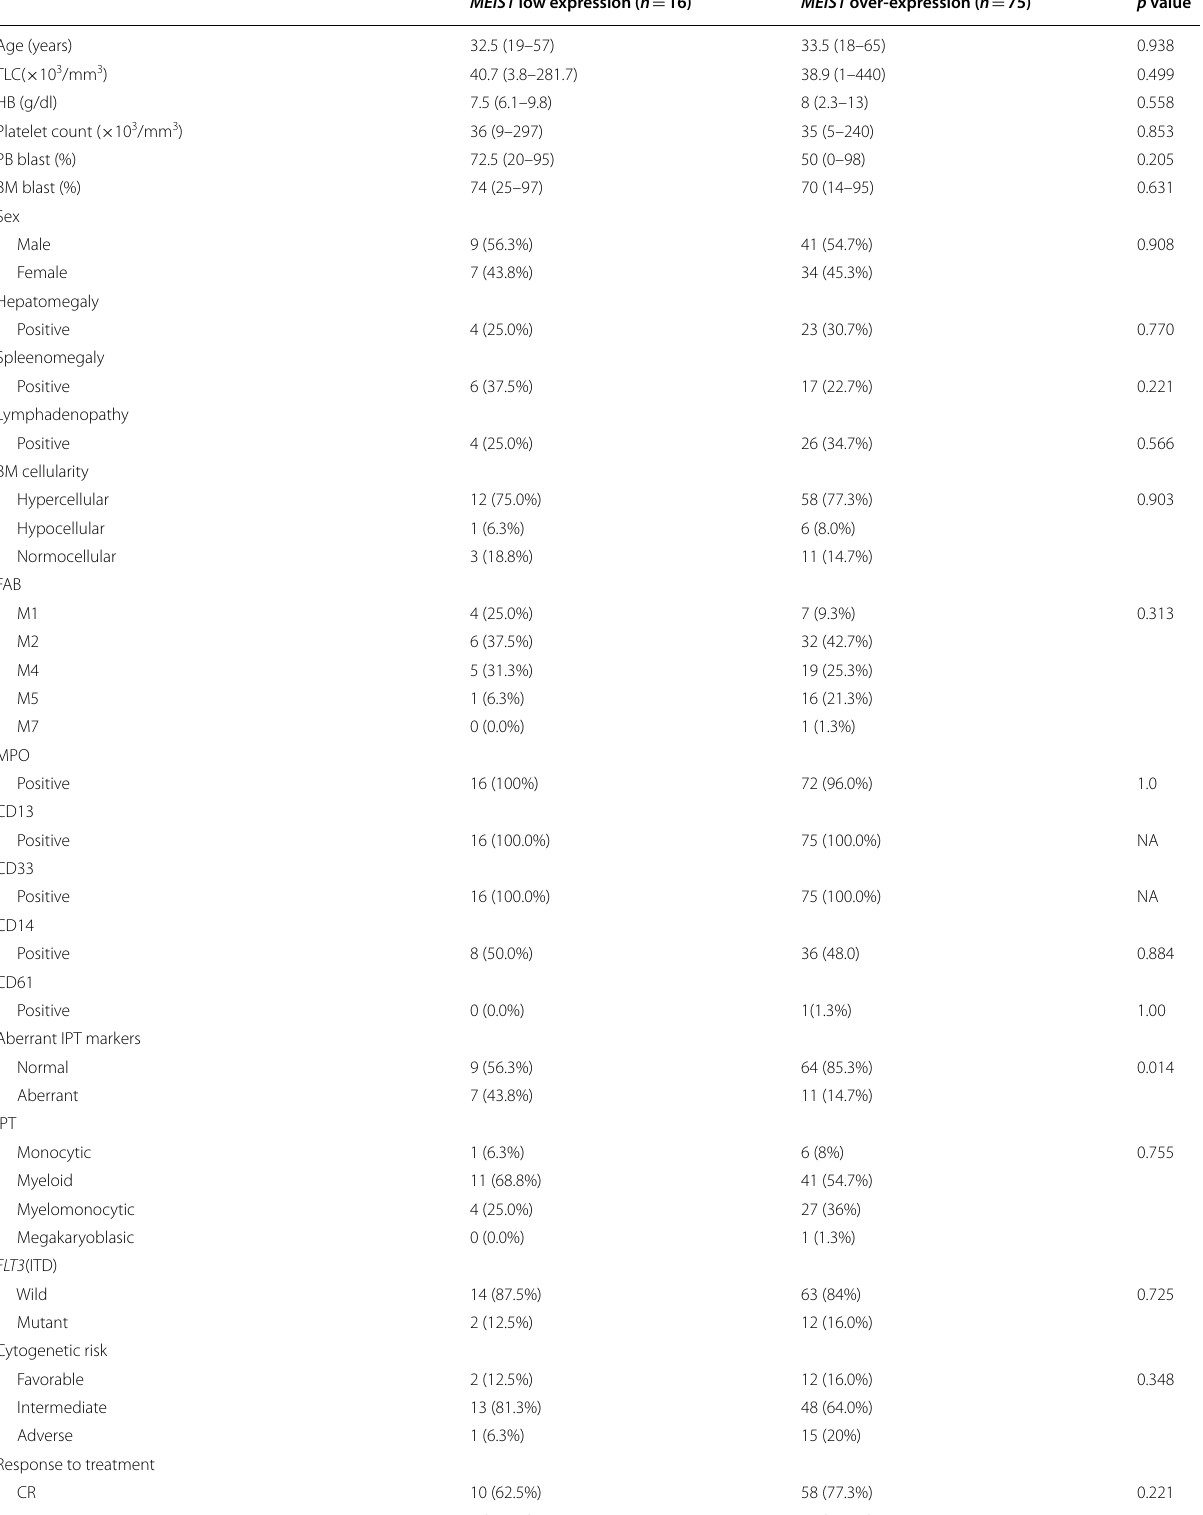
Table 4 Association between patients’ characteristics and MEIS1 gene